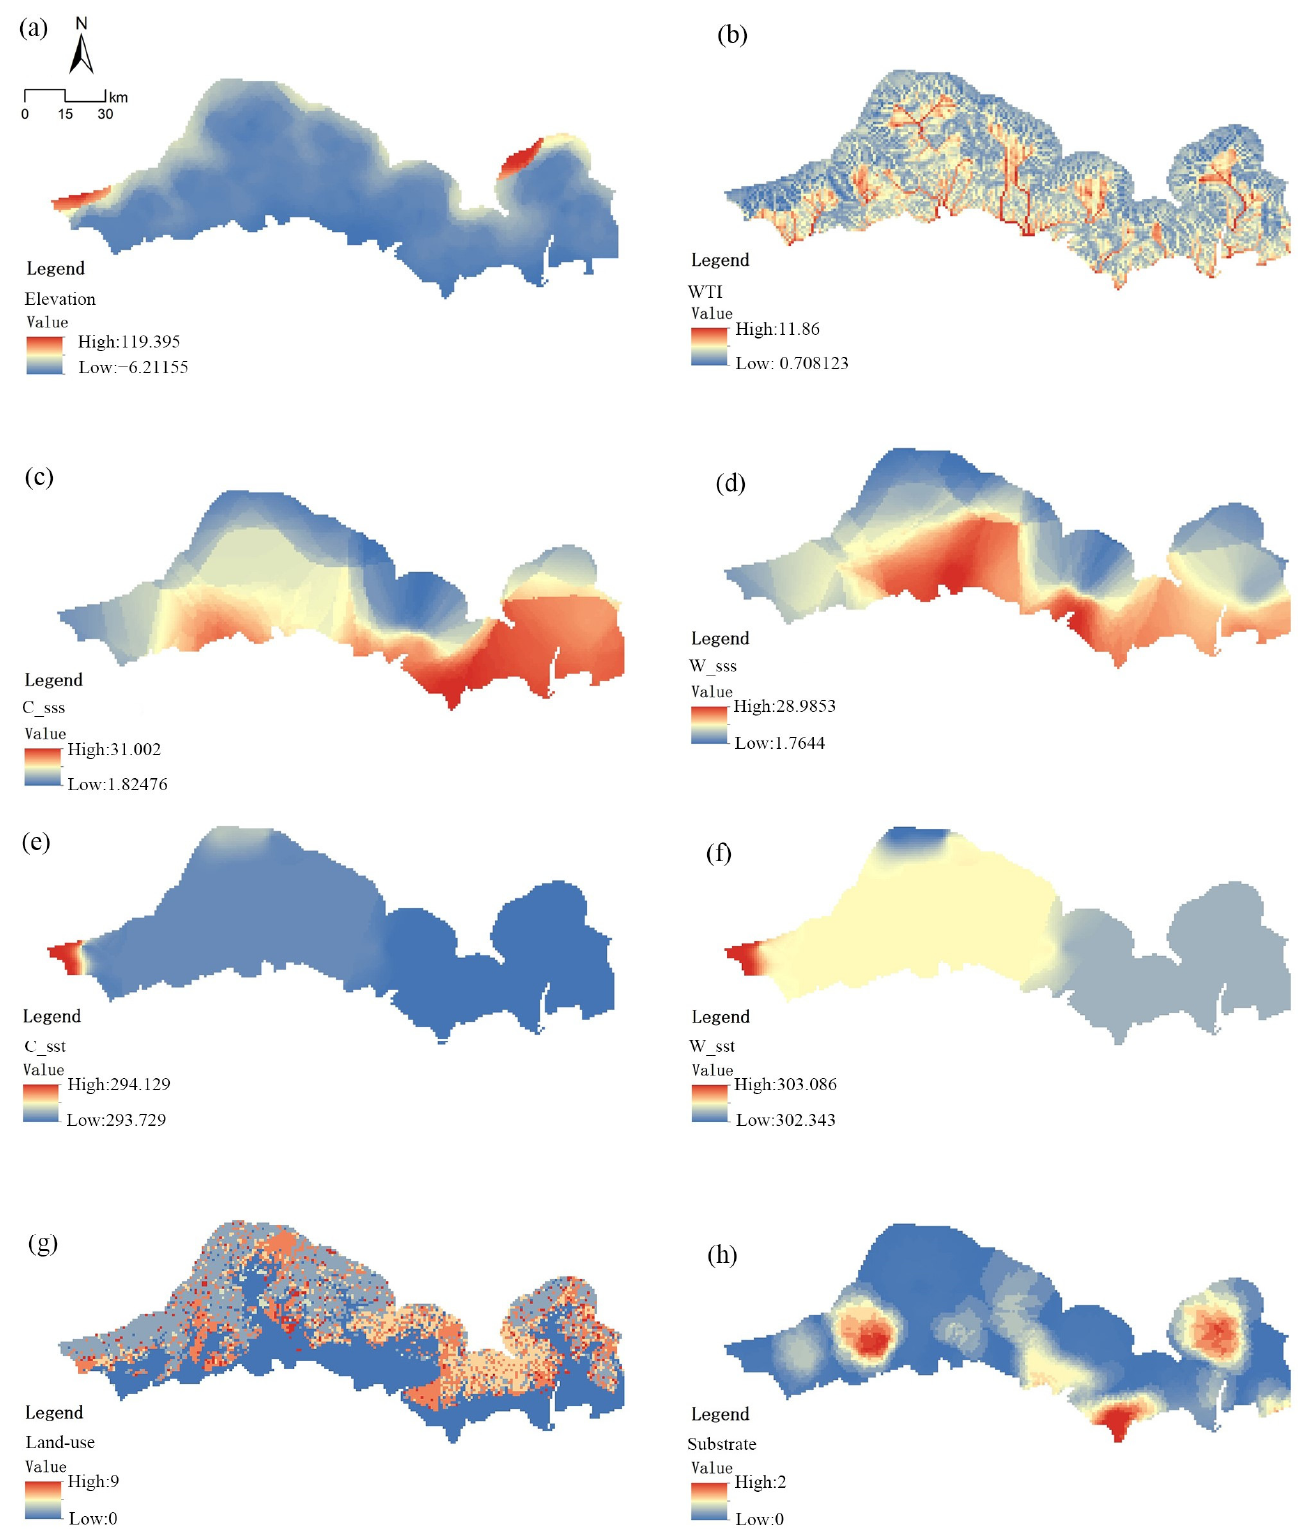
Figure 4. Environment variables. ( a ) Elevation, ( b ) WTI, ( c ) C_sss, ( d ) W_sss, ( e ) C_sst, ( f ) W_sst. ( g ) Land-use, ( h ) Substrate.